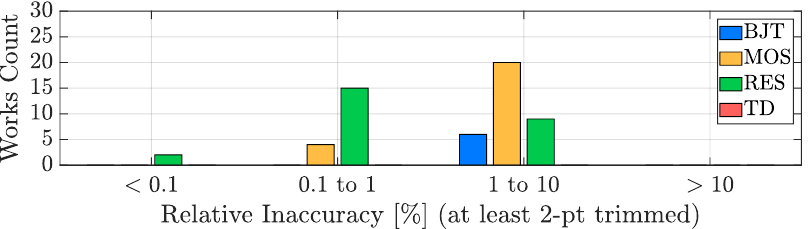
Figure 15. 2-pt (or more) trimmed TDC inaccuracy performance distribution with sensing-type distinction.